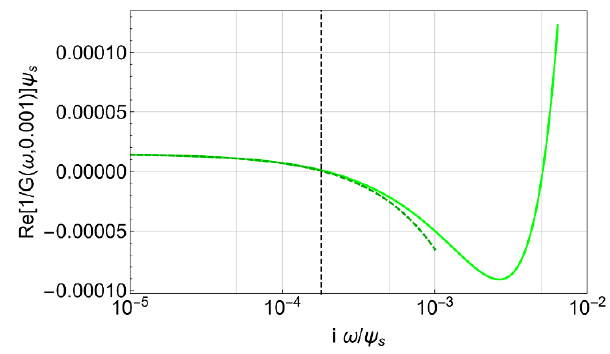
Figure 5 . We compare the analytic (dashed) and the numerical (solid) result for the two point function G ( !; 0 : 001) for purely imaginary